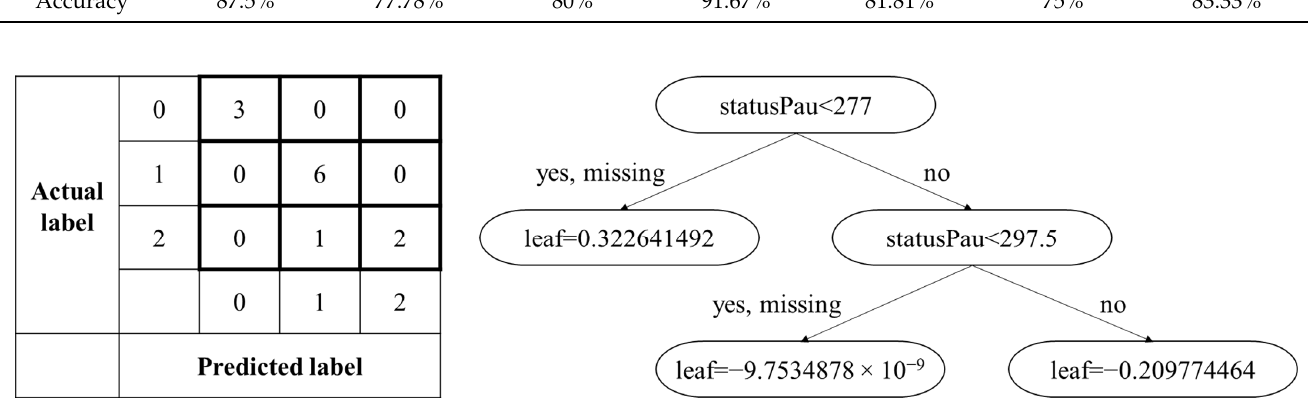
Figure 8. Confusion matrix (input) and decision tree (output) of XGBoost (six-day